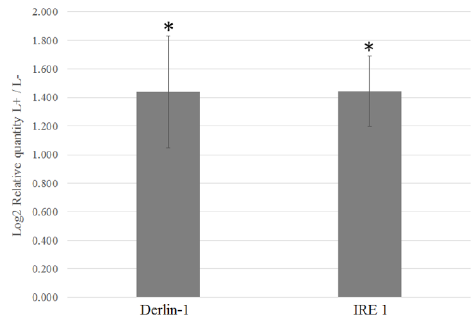
Figure 5. Relative quantification of Derlin-1 and IRE1 genes (Log 2 expression) in CLas-infected Diaphorina citri by qPCR relative to uninfected insects. Asterisks above columns indicate statistically significant difference when compared to the uninfected control.